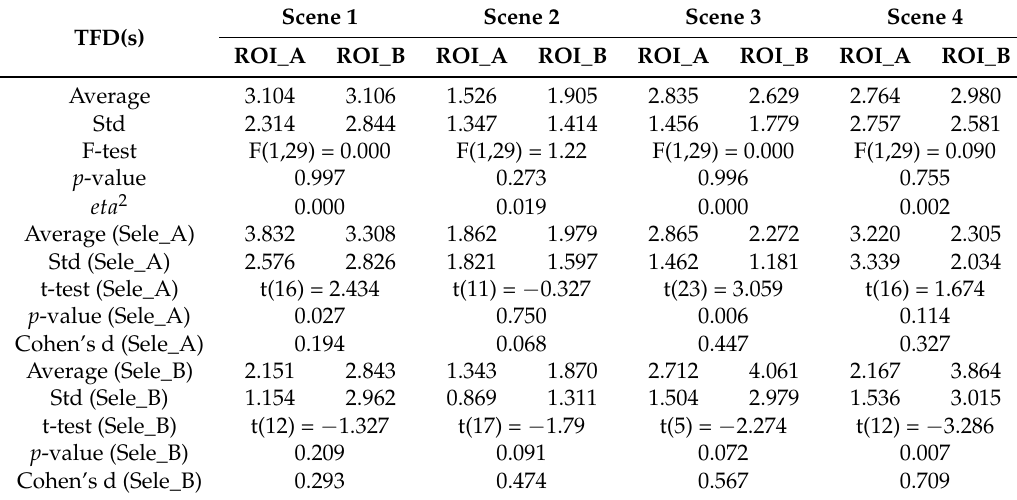
Figure 4. Scene 1 after tagging different regions of interest (ROIs): ROI_S, ROI_A, and ROI_B. Table 1. Statistical analysis of total fixation duration (TFD) for the four scenes in both